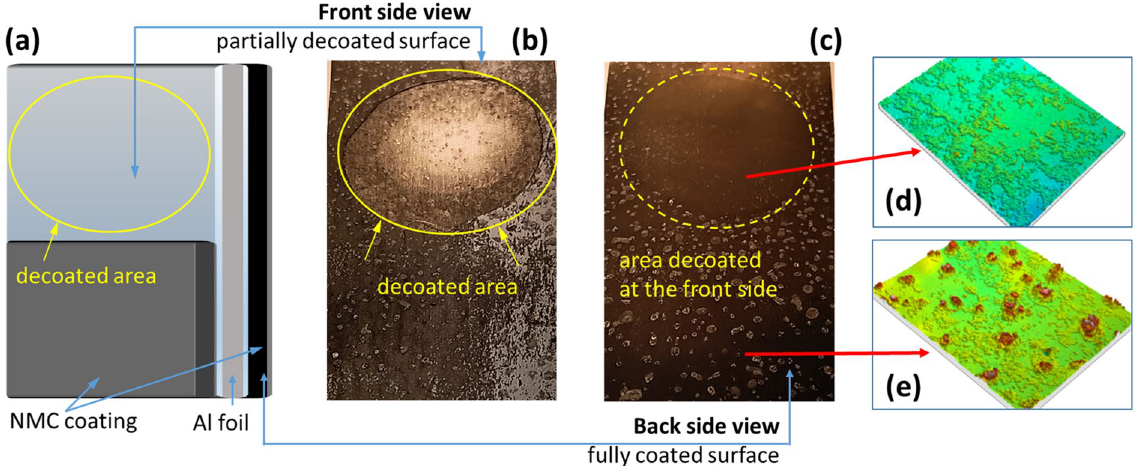
Figure 2. ( a ) Schematic illustration of the partially decoated positive electrode; ( b ) optical image of the partially decoated front side and of ( c ) the fully coated back side after aging in air humidity of φ = 97% for 18 h; confocal microscope images electrode surface taken ( d ) from the apparently non-corroded area with decoating on the surrounding side and ( e ) the surrounding corroded electrode surface formed in areas with NMC coating on both sides; light–dark patterning seen inside the yellow circle in the optical image ( b ) and ( c ) are only due to light